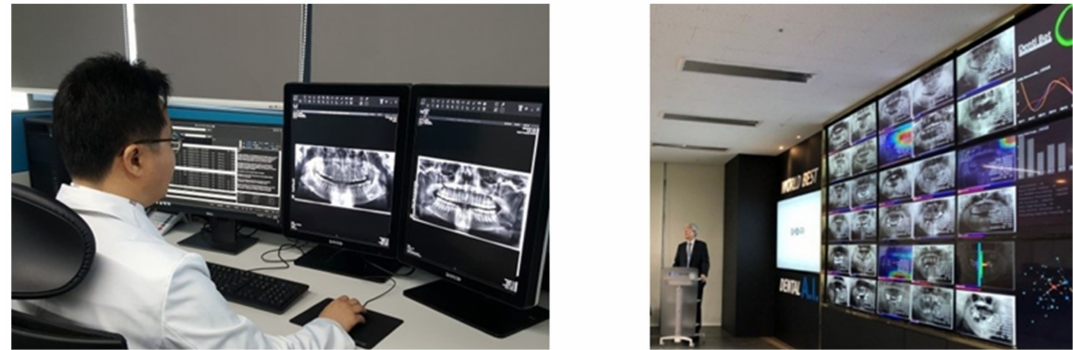
Figure 9. Actual usage of expert